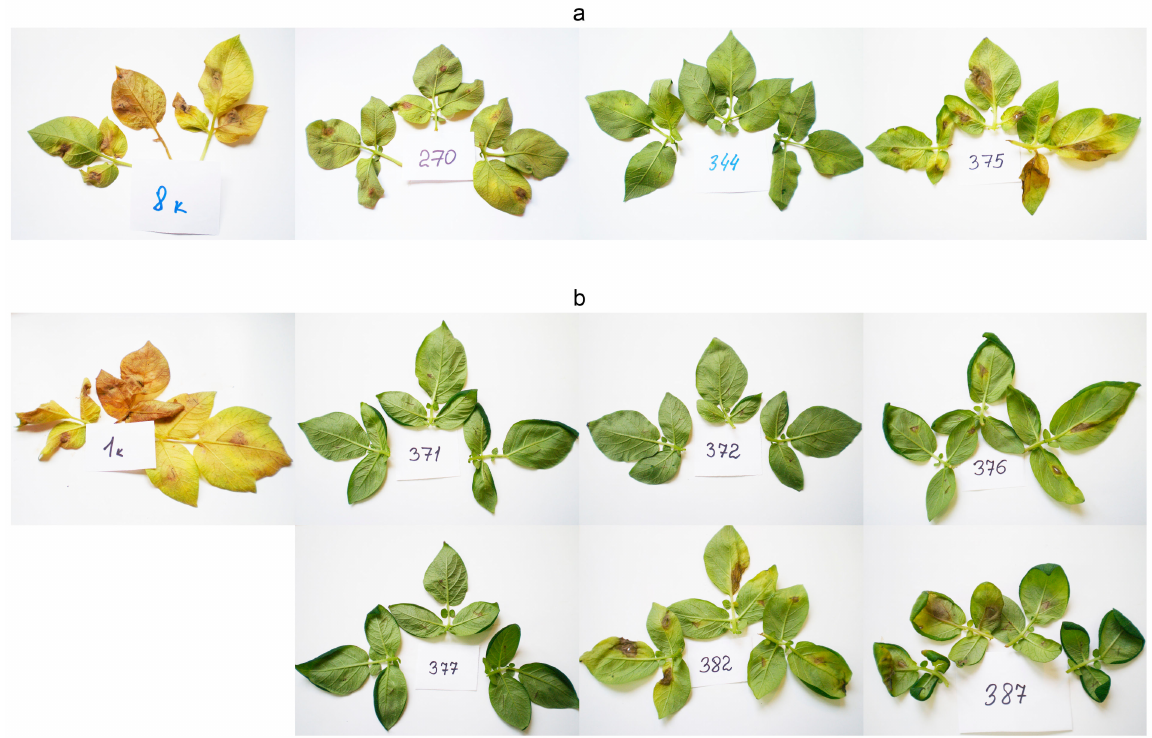
Figure 4. Early blight symptoms in the Alternaria spp. inoculated leaves of initial potato varieties and their respective transgenes: ( a ) Udacha and its transgenic lines 270, 344 and 375. Photos were taken in 2015; ( b ) Zhukovsky ranny and its transgenic lines 371, 372, 382, 376, 377 and 387. Photos were taken in